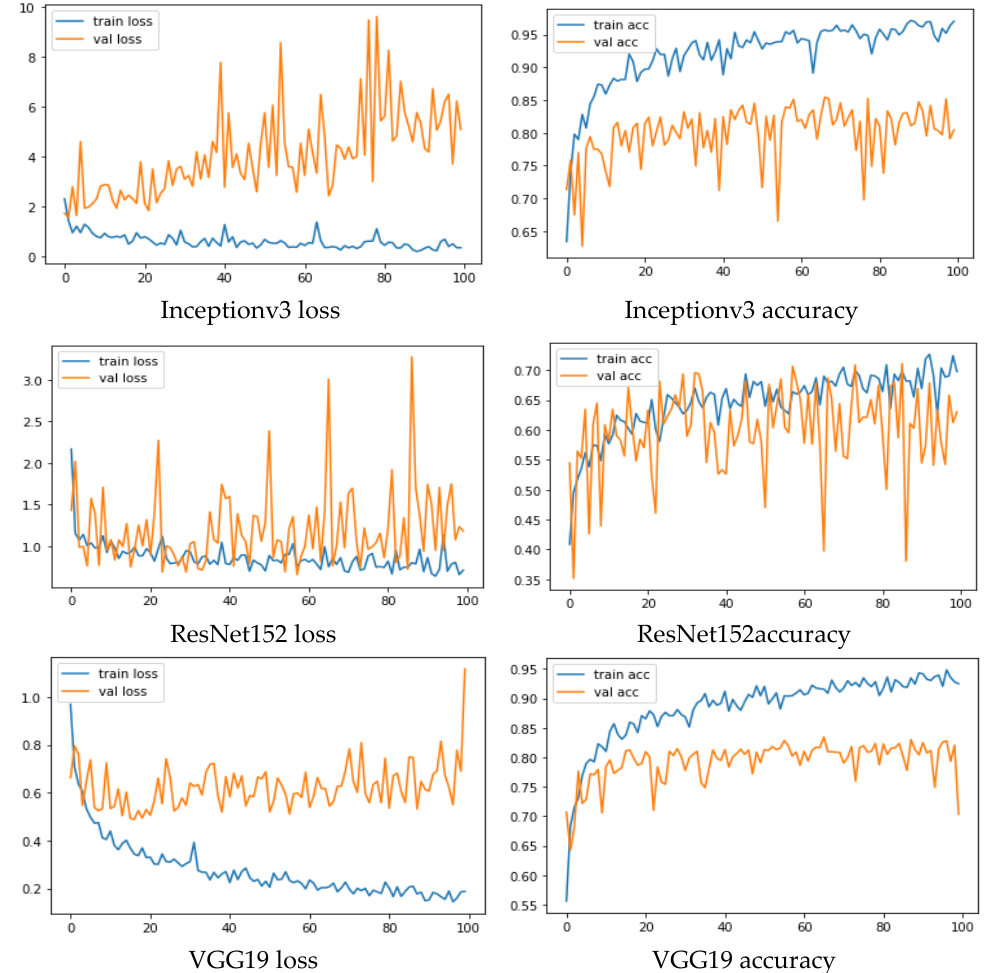
Figure 6. Graphical representation of transfer learning techniques. Table 5. Performance comparison of transfer learning techniques.